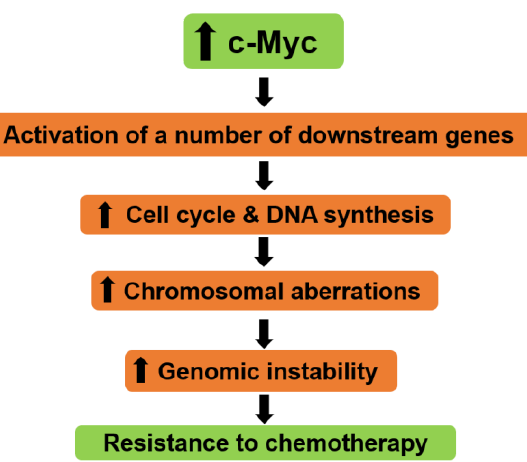
Figure 4. Roles of c-Myc in chemotherapy resistance. Overexpression of c-Myc may result in activation of several downstream genes, which leads to a promotion of cell cycle with DNA synthesis and an increase in chromosomal aberrations. These mechanisms ultimately initiate genomic instability and chemoresistance. The upper head arrows indicate increase while the lower ones indicate the